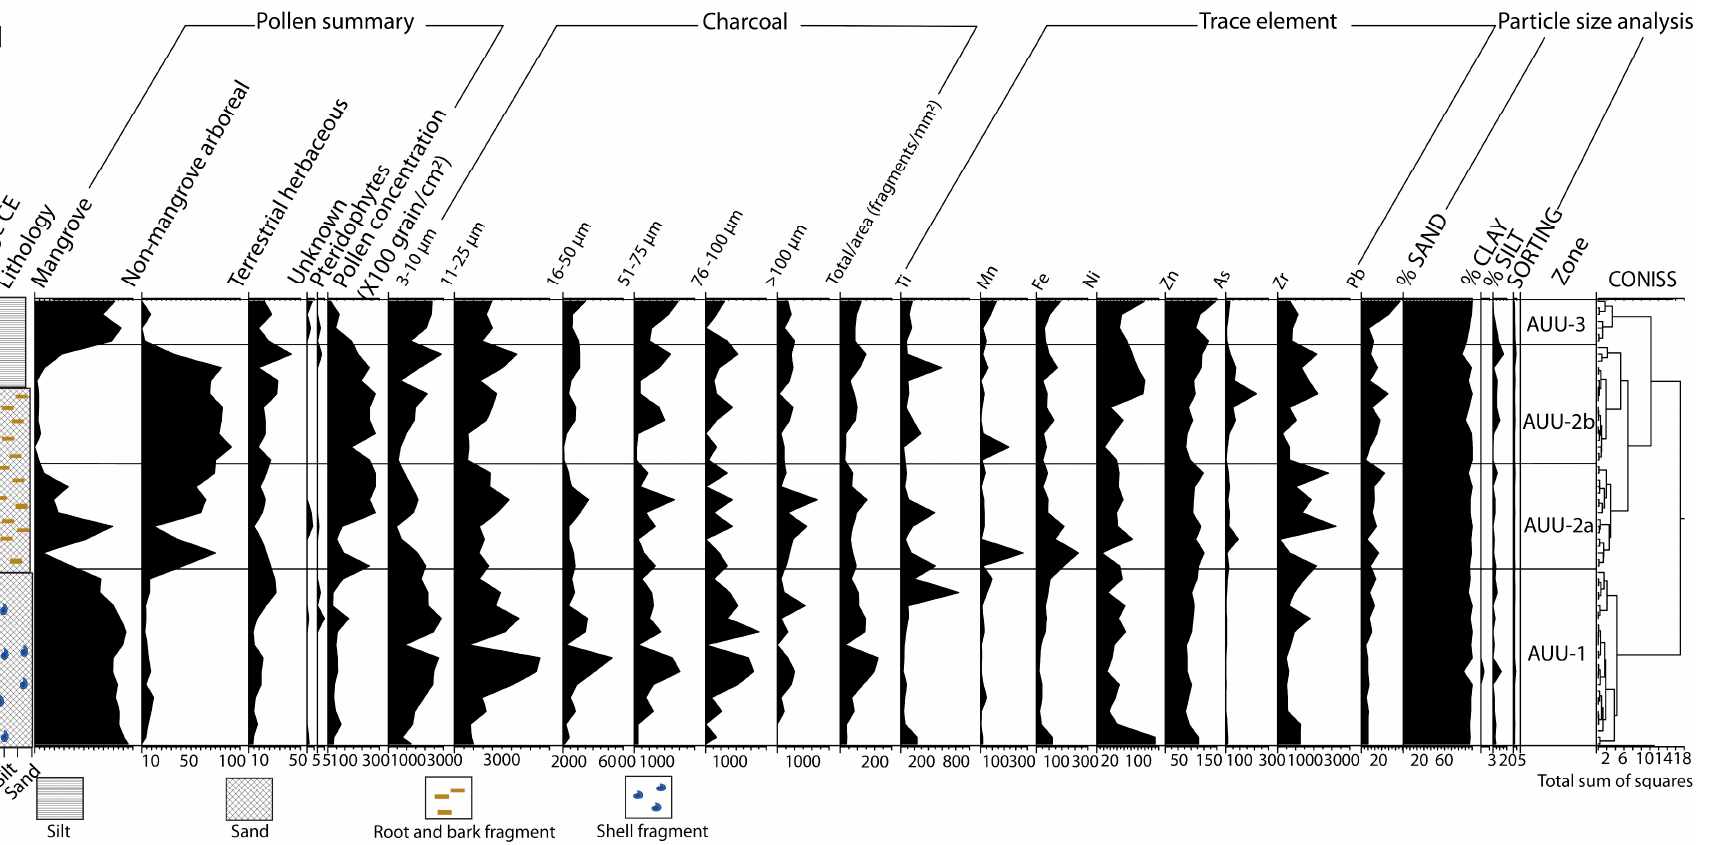
Figure 7. Frequency plot showing pollen summary, charcoal, trace elements and particle size data from AUU1 core. Zonation is based on a cluster analysis of pollen data.